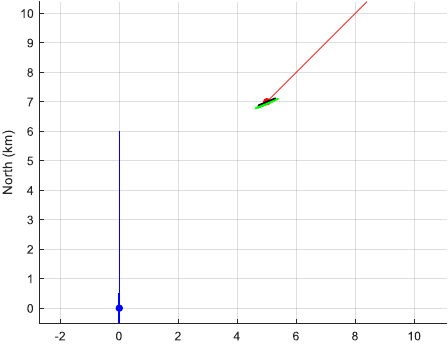
Figure 5. The cloud of estimated position (in green) for 𝜎 = 1.7 × 10 −4 . The cloud is no longer hyperbola-shaped. The small black segment is the 90%-confidence ellipsoid. Table 2. Performance of the estimator of the reduced state vector with 𝜎 = 1.7 × 10 −4 .